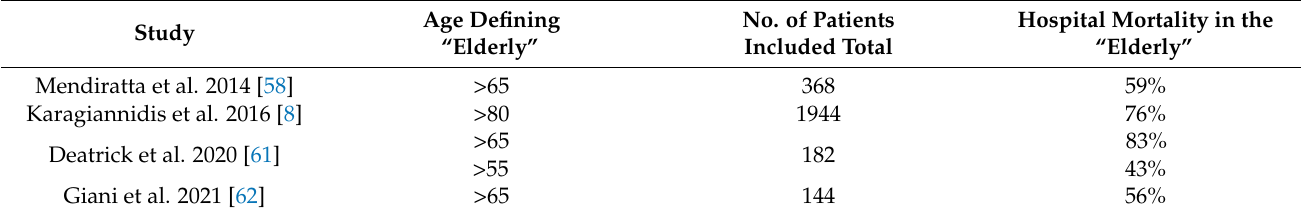
Table 3. Evidence for the use of vvECMO in elderly patients and the respective outcome.